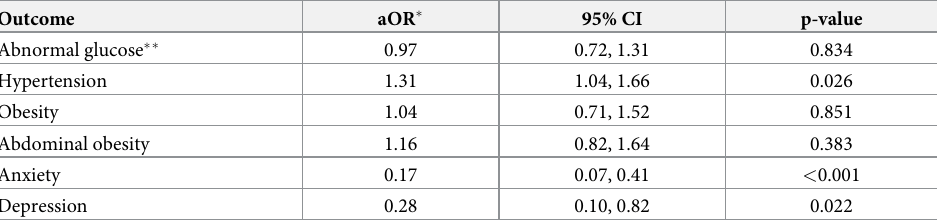
Table 4. Multivariable logistic regressions of NCD outcomes and survey exposure, adjusted for socio-demo- graphic factors.